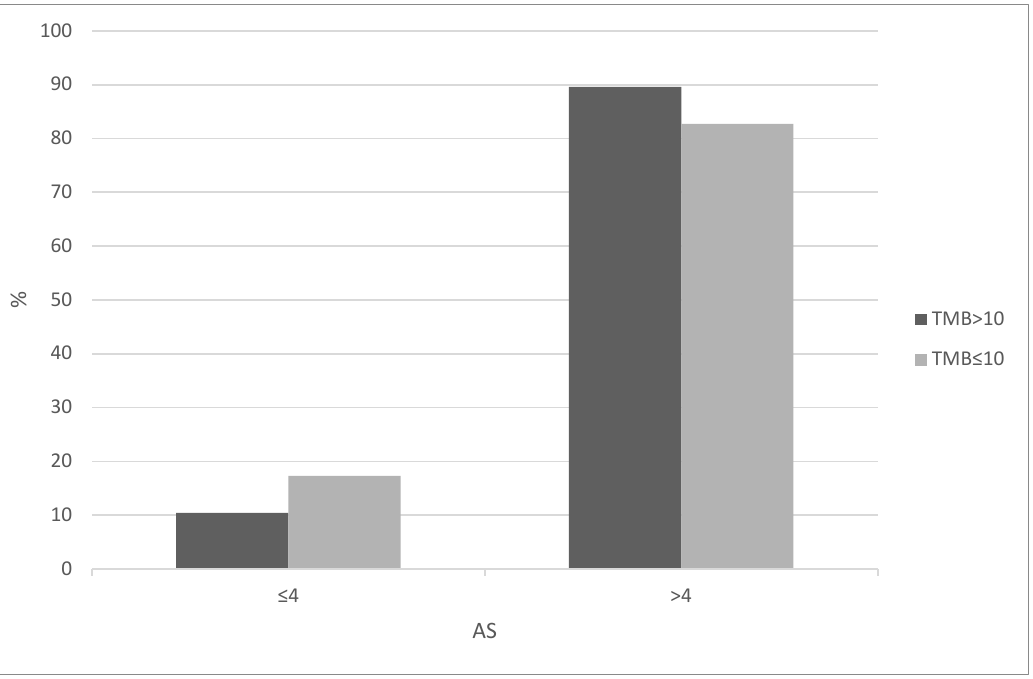
Figure 5. Aneuploidy Scores (AS) of above or below 4 in bladder carcinomas according to TMB. High TMB group: TMB > 10 mutations/MB, low TMB group: TMB ≤ 10 mutation/MB. Data are from TCGA. TMB: Tumor Mutation Burden.